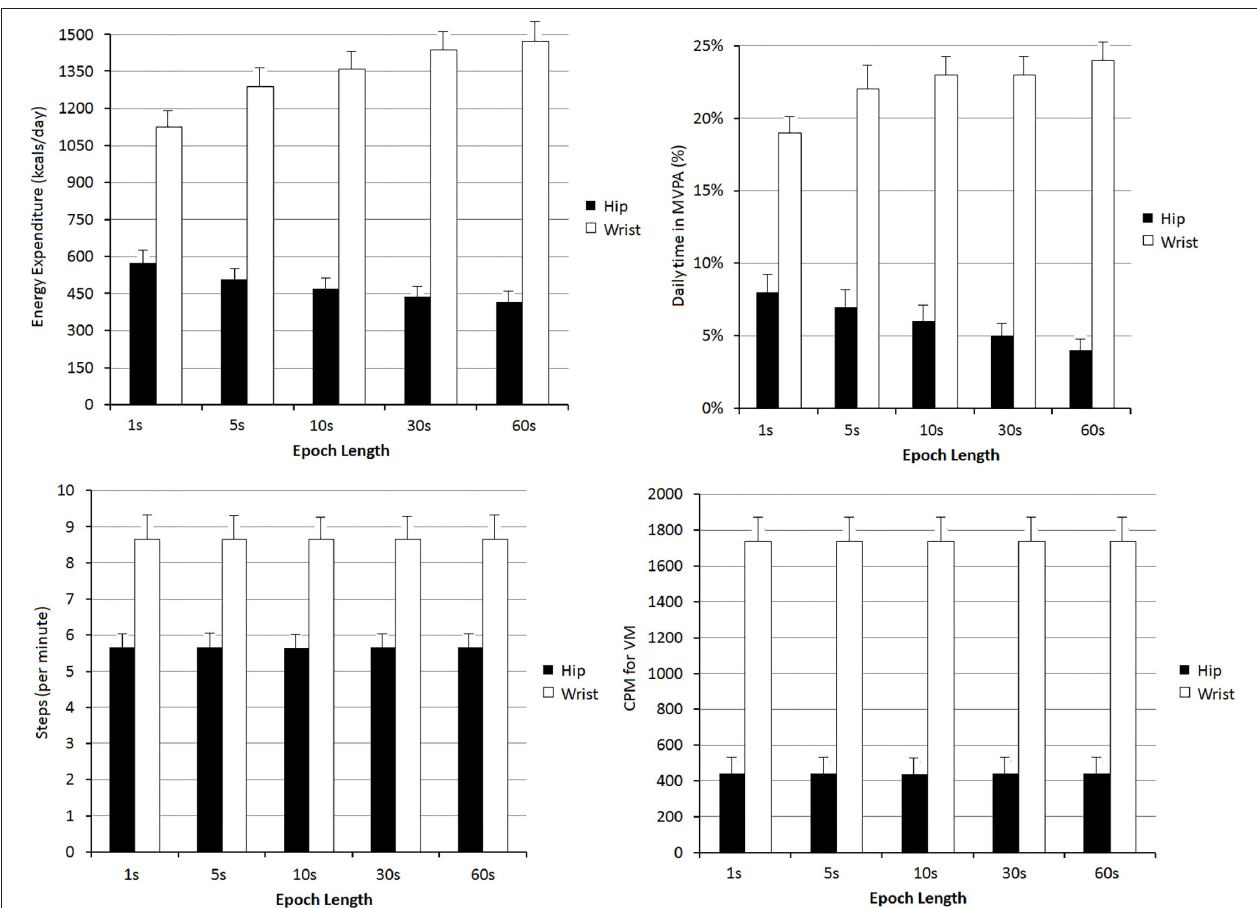
FIGURE 2 | Levels of energy expenditure, daily time in moderate-to-vigorous physical activity (MVPA%), steps per minute and vector magnitude (VM) counts per minute (CPM), found depending on the registration site (hip or wrist) and the epoch length: 1, 5, 10, 30, and 60s. All comparisons between hip and wrist records were statistically significant ( p < 0.05). For the same recording site (hip or wrist), the levels of Energy Expenditure and daily time in MVPA% were different ( p < 0.05) when comparing the values obtained with different epoch